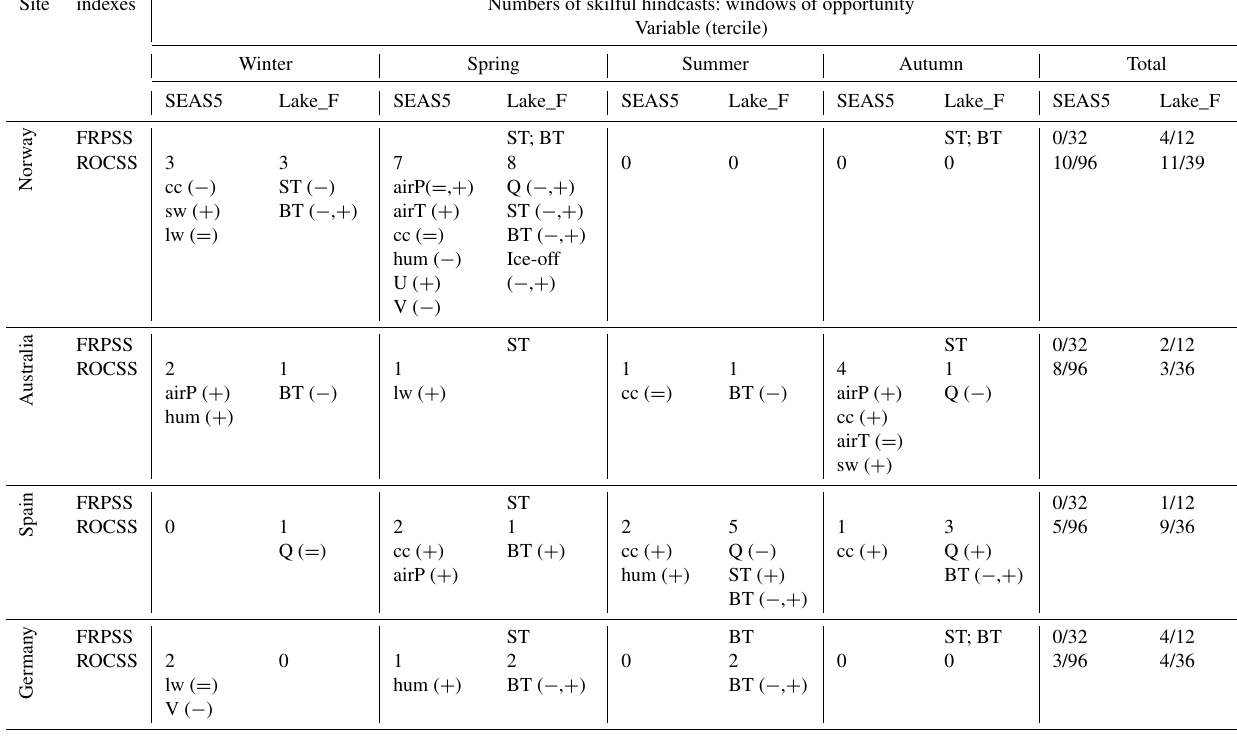
Lake_F variable abbreviations: ST, BT and Q stand for surface temperature, bottom temperature and discharge, respectively. SEAS5 meteorological variable abbreviations: airT, airP, cc, hum, sw, lw, and U and V standforsurfaceairtemperature,airpressure,cloudcover,relativehumidity(ordewpointtemperature),short-waveradiation,downwellinglong-waveradiation,and u and v componentsofwind, respectively. − , + and = stand for lower, upper and middle terciles,